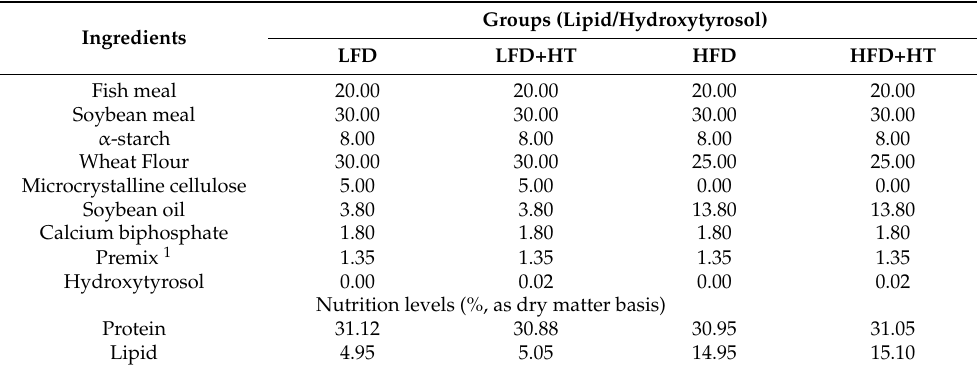
Table 1. Formulation and proximate composition of the experimental diets (% dry